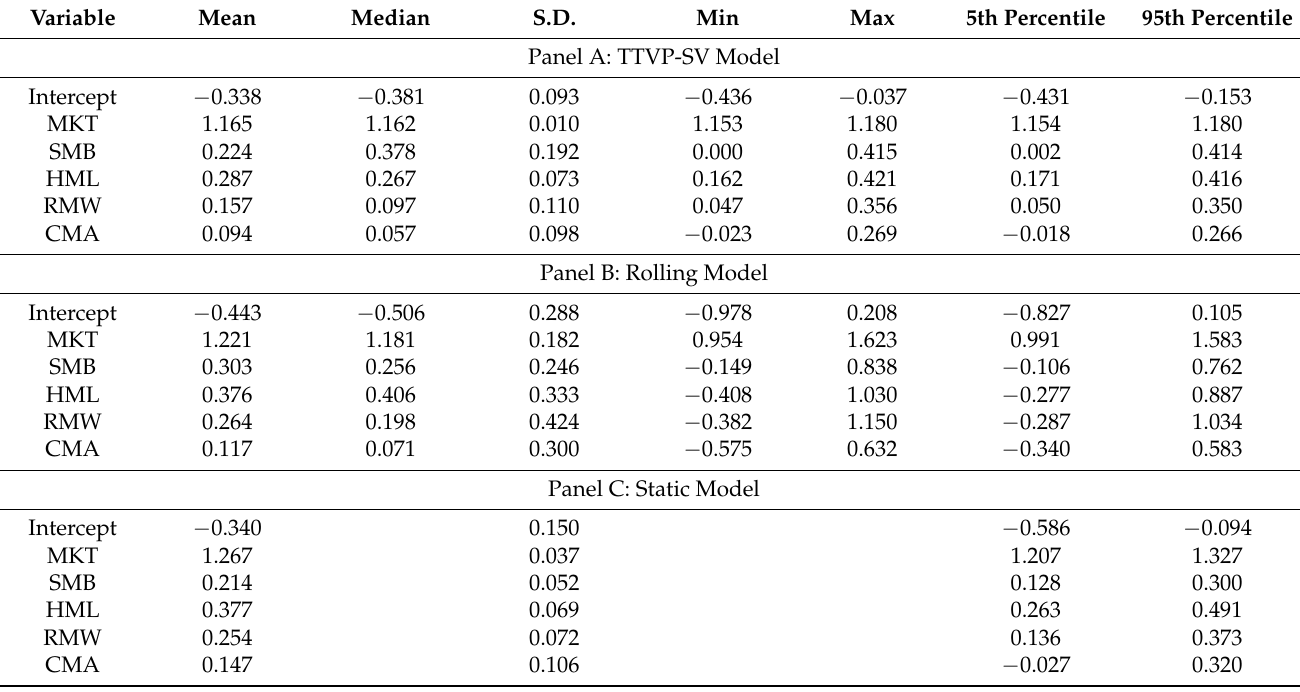
Table 2. Time-varying, rolling and static factor betas—Consumer